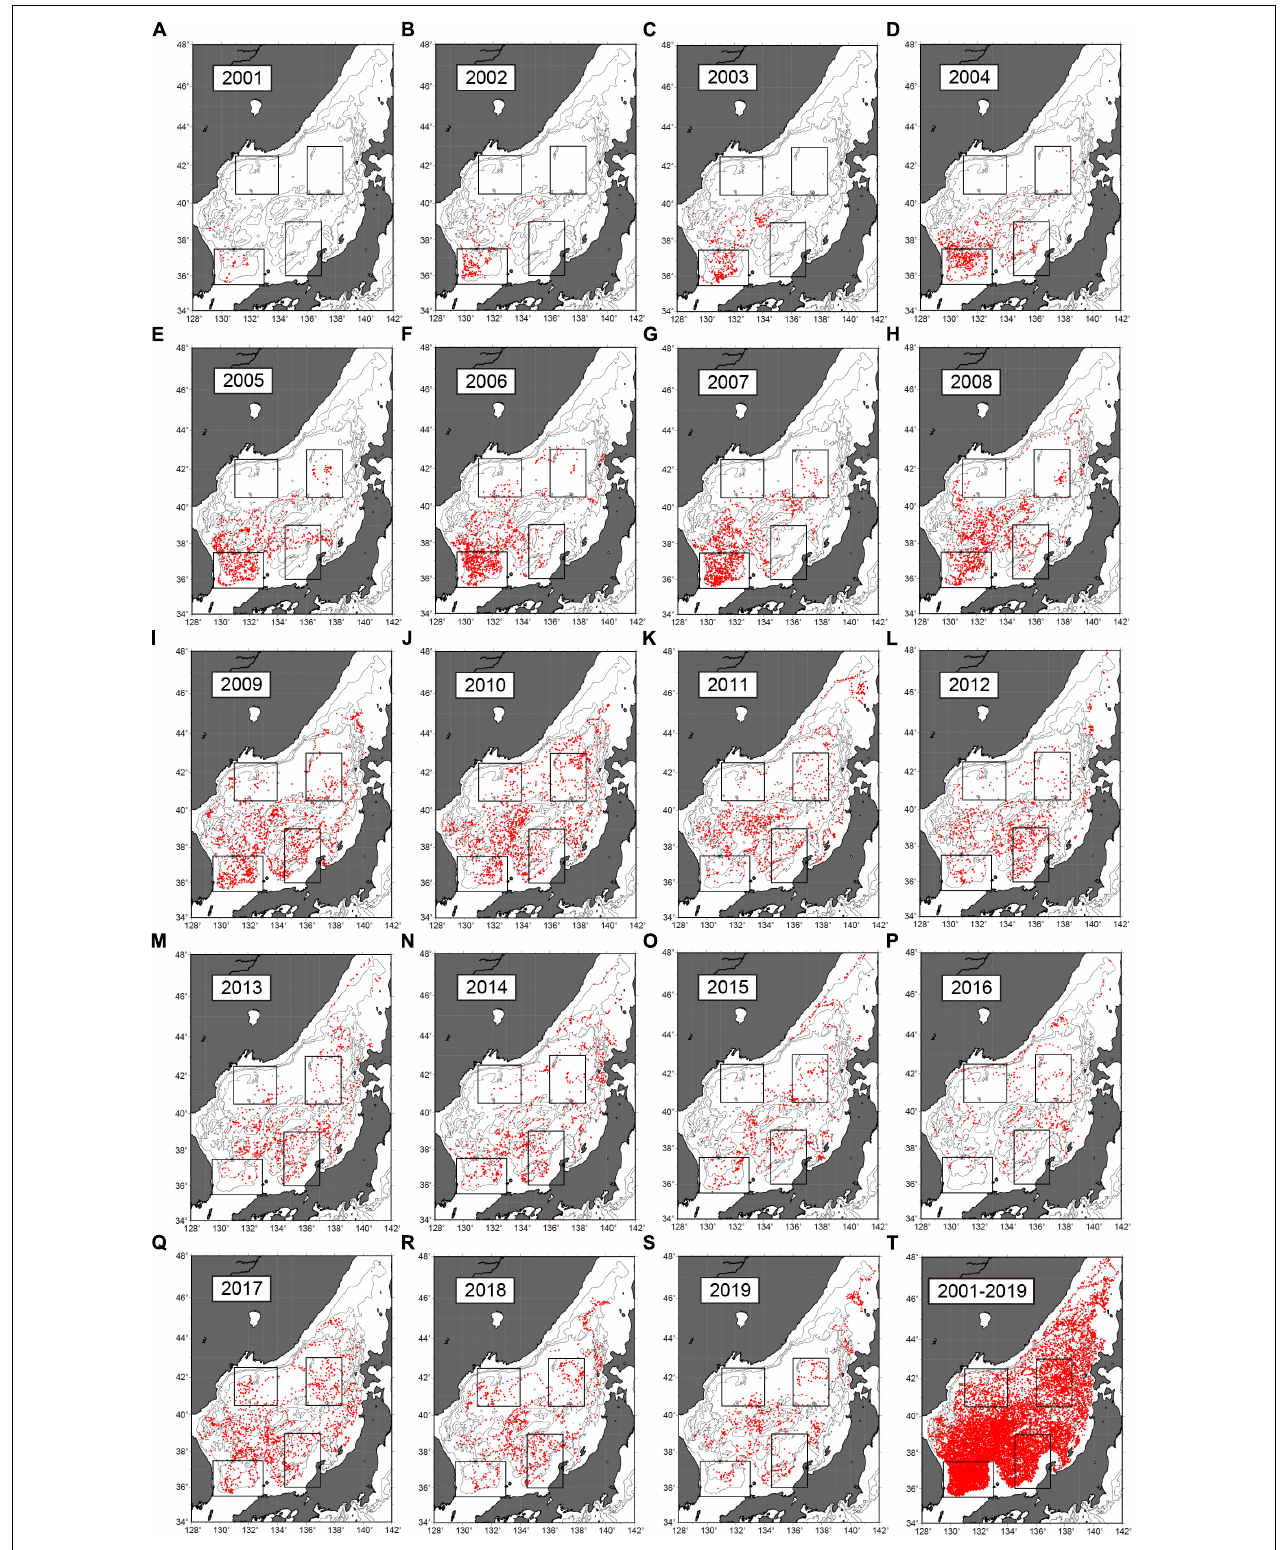
FIGURE 3 | Distributions of Argo float data in each year: (A) 2001, (B) 2002, (C) 2003, (D) 2004, (E) 2005, (F) 2006, (G) 2007, (H) 2008, (I) 2009, (J) 2010, (K) 2011, (L) 2012, (M) 2013, (N) 2014, (O) 2015, (P) 2016, (Q) 2017, (R) 2018, and (S) 2019. Total distribution from 2001 through 2019 is shown in (T) . Black squares indicate JW, JE, YB, and TB in Figure 1